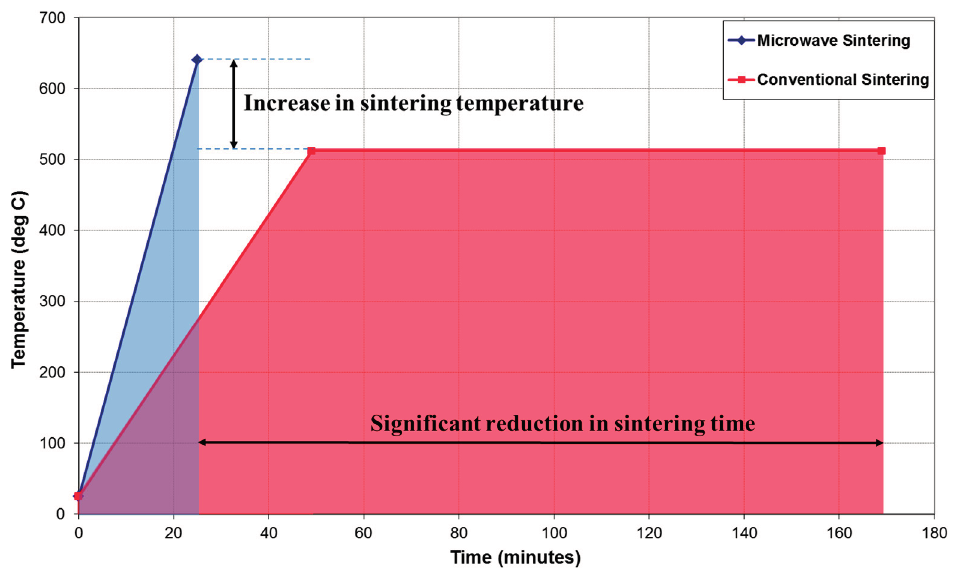
Figure 2. Comparison of sintering profile between conventional and microwave sintering for magnesium.